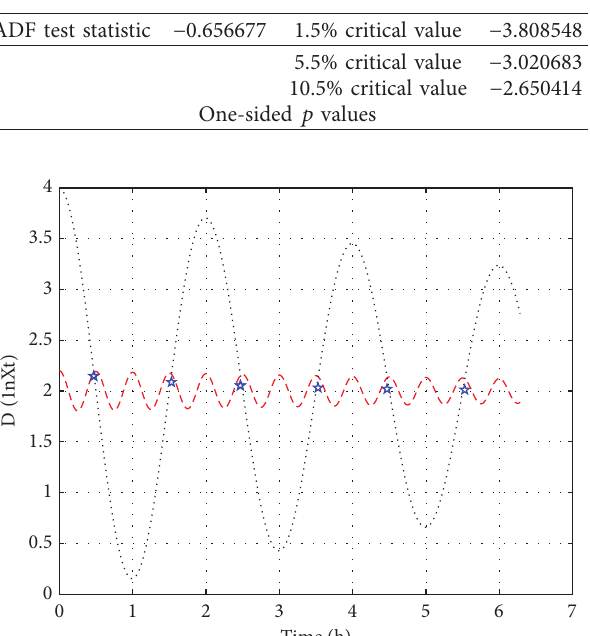
Table 2: Results of the 1nXt unit root test.